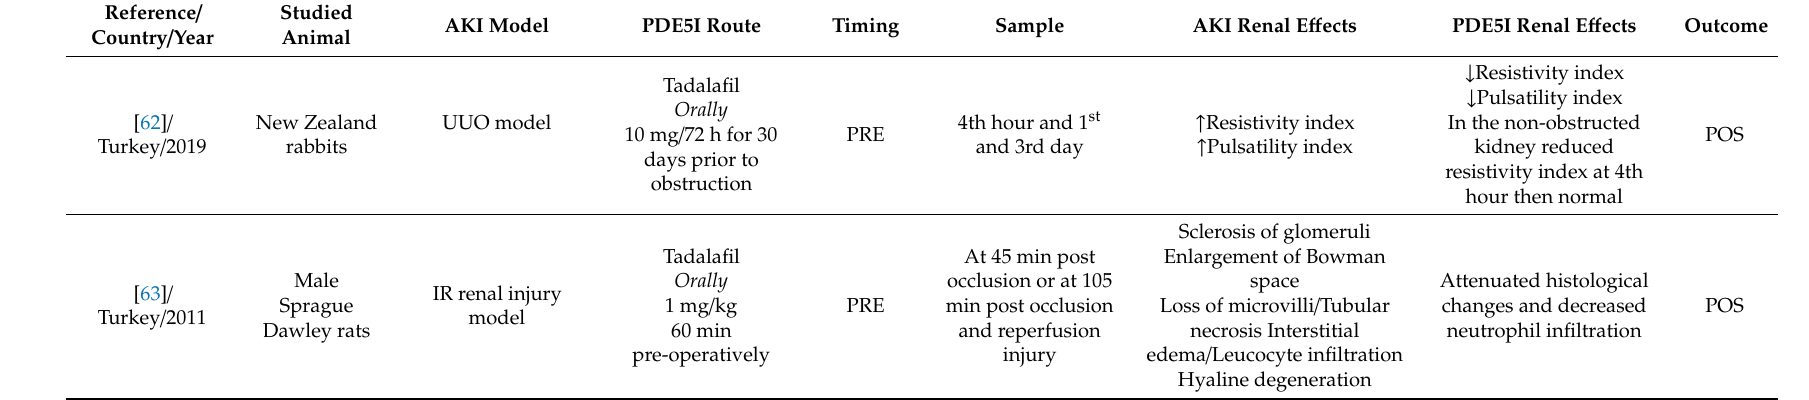
Table 3. Animal studies evaluating the potential reno-protective e ff ects of